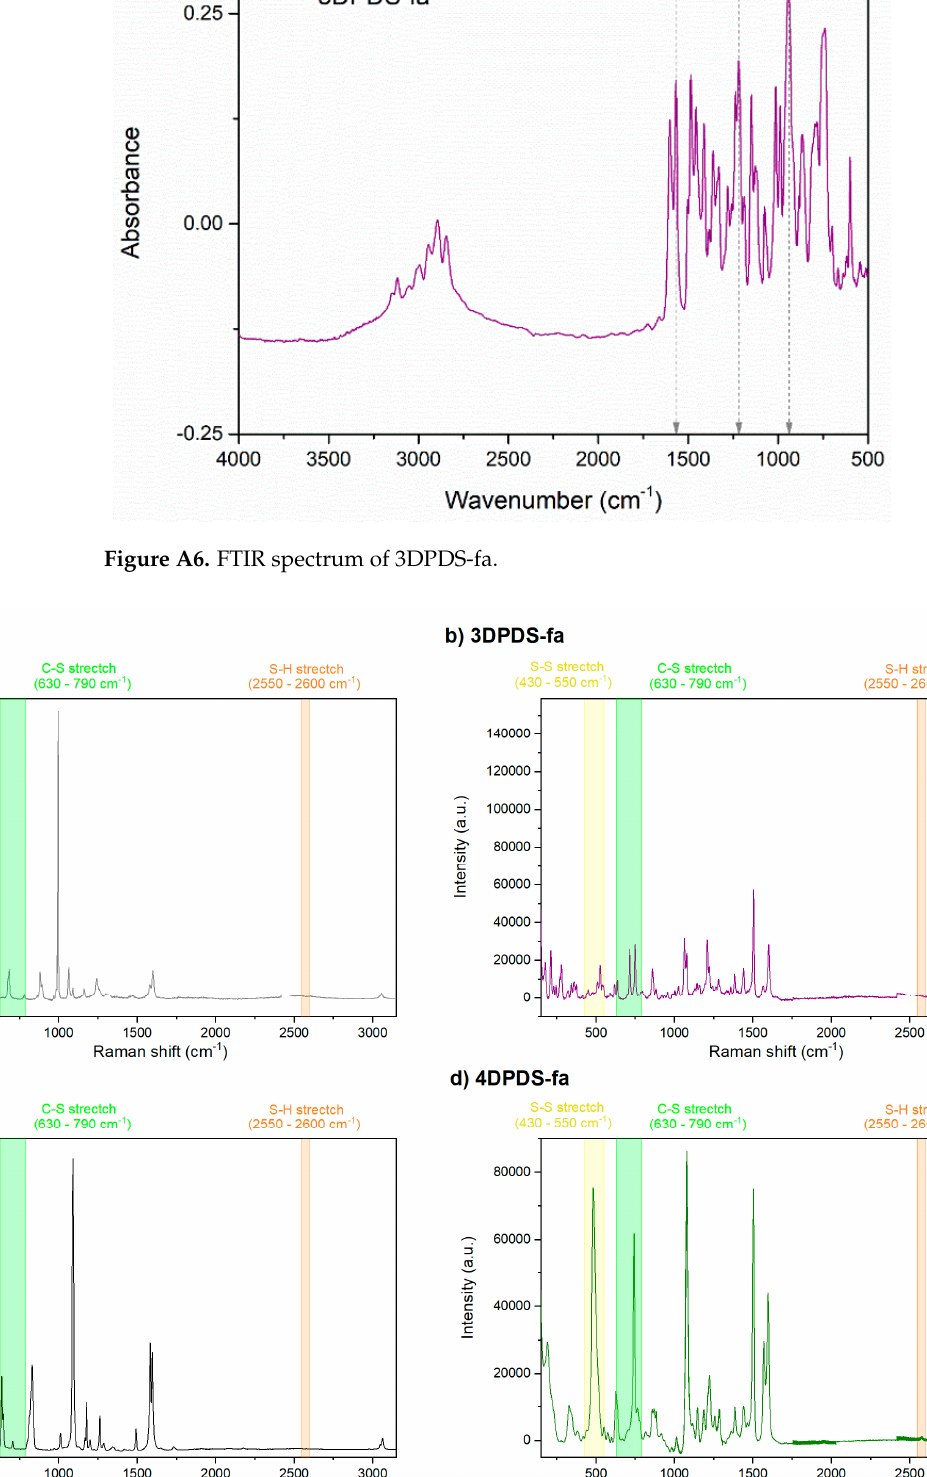
Figure A7. Raman spectra of ( a ) 3DPDS; ( b ) 3DPDS-fa; ( c ) 4DPDS; and ( d ) 4DPDS-fa.